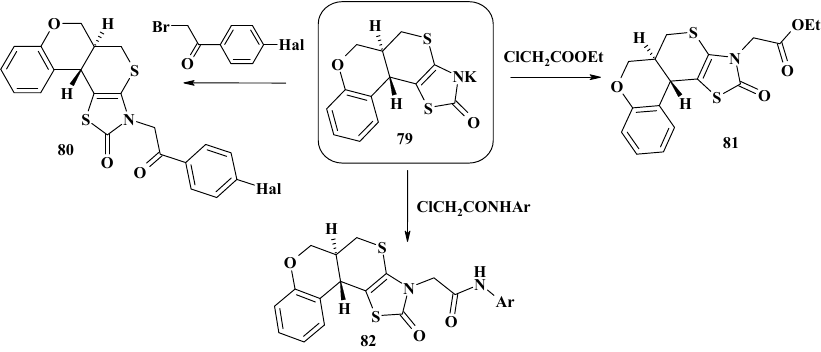
Scheme 27. Synthesis of 3-substituted chromeno[4 ′ ,3 ′ :4,5]thiopyrano[2,3- d ]thiazole-2-ones. Using the same approach (Scheme 28), isothiochromeno[4a,4- d ]thiazole-2-one 75 was alkylated